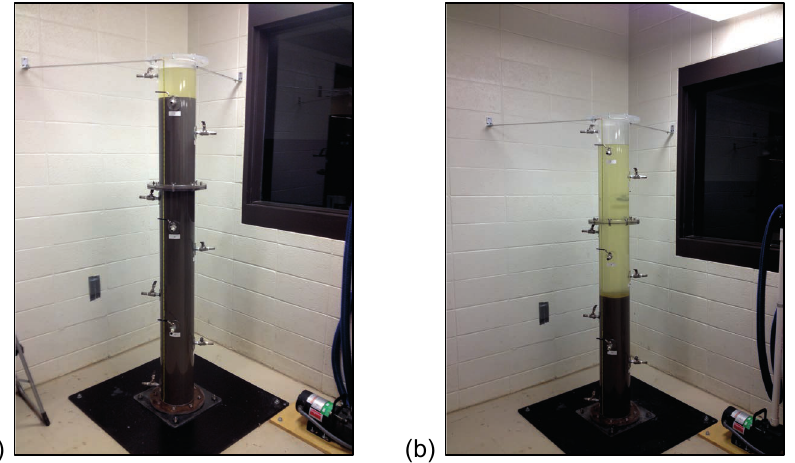
Fig. 2 Column settling test in progress (a) end of 6 hours, (b) end of 4 days for test 2013-5.